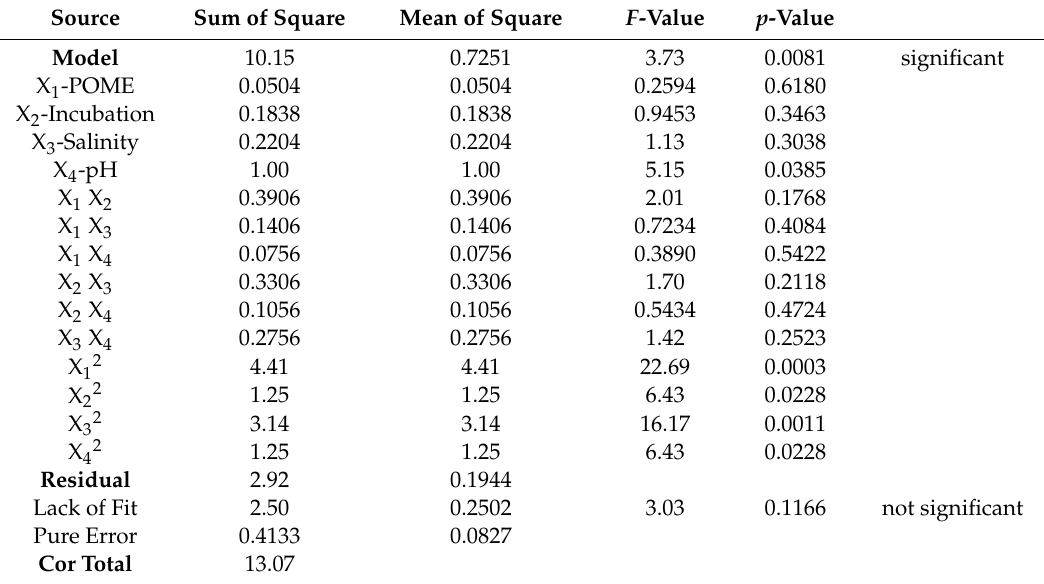
Table 3. ANOVA oil displacement area model test at response surface methodology